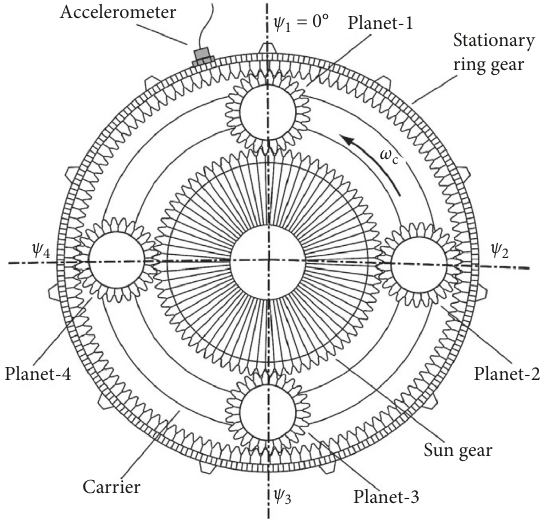
Figure 4: A schematic of a 4-planet PGT with an accelerometer mounted on the ring gear